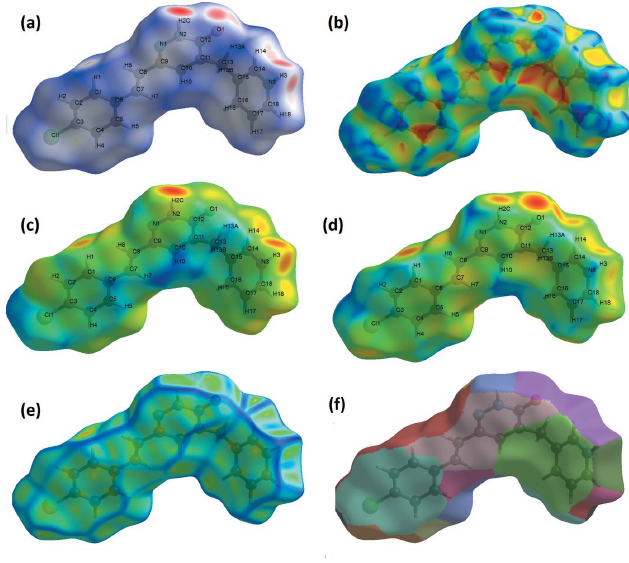
Figure 4 Graphical depictions of the molecular Hirshfeld surfaces; ( a ) d norm , ( b )shape-index, ( c ) d i , ( d ) d e ,( e ) curvedness and ( f ) fragment-path.